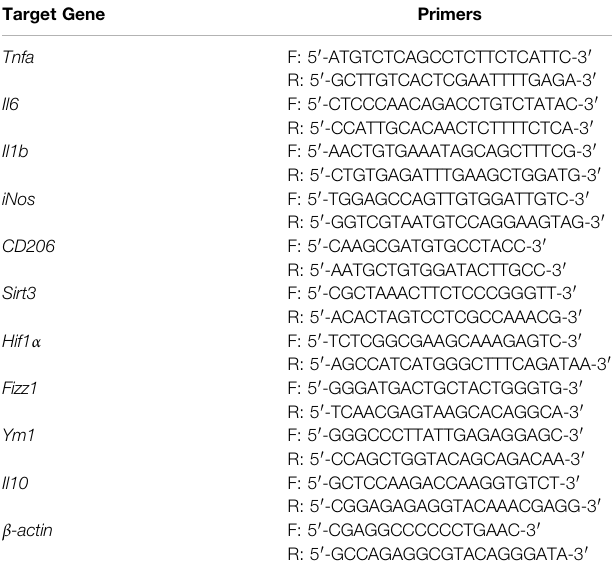
TABLE 1 | Sequences of primers used in